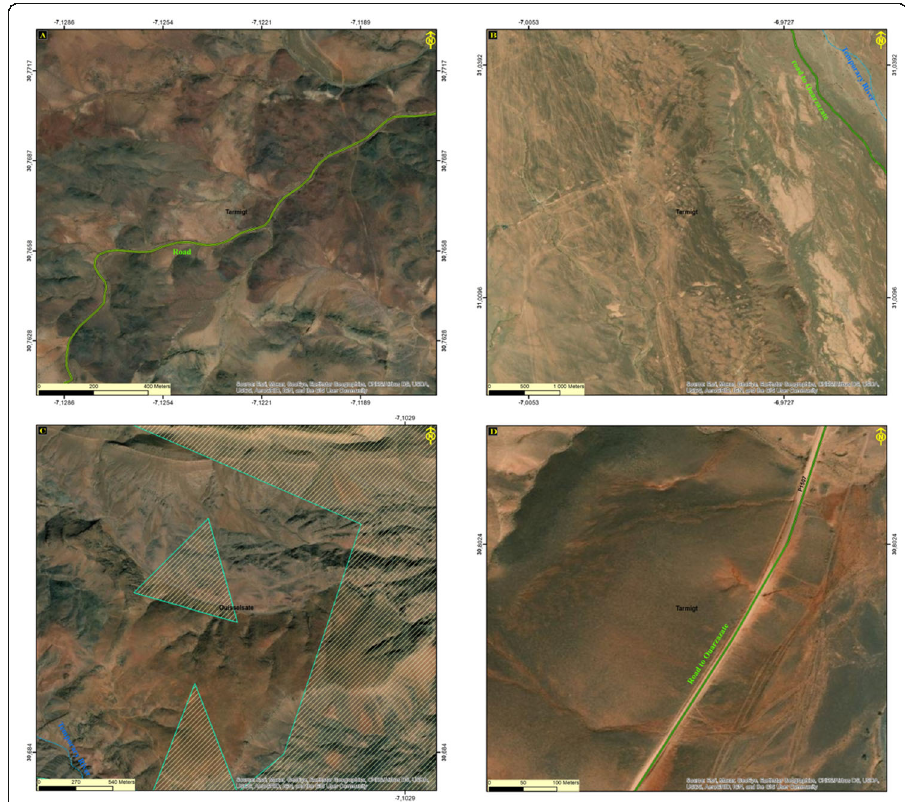
Fig. 13 Satellite views of provisionally selected sites (Source: Esri, Maxar, GeoEye, Earthstar Geographics, CNES/Airbus, DS, USDA, AeroGRID, IGN, and the GIS User